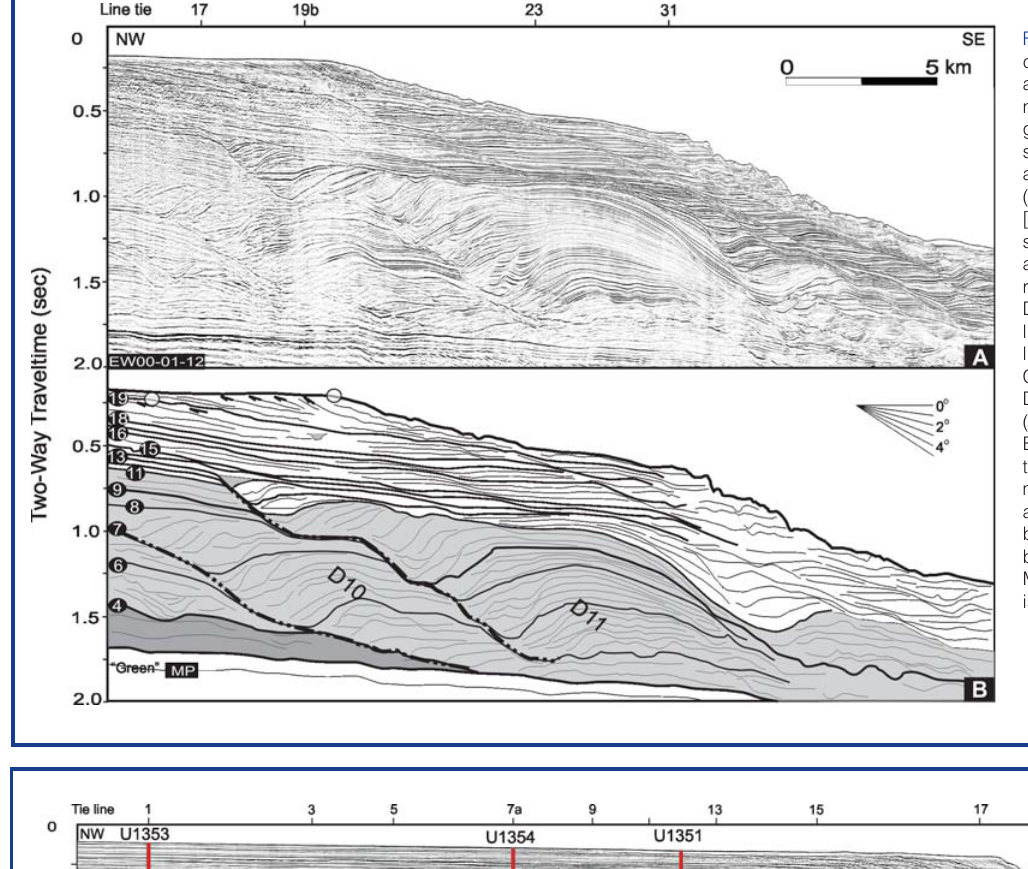
Figure 5. [A] Uninterpreted dip profile EW00-01-12 across the slope in the northern part of the survey grid showing mounded s e d i m e n t d r i f t s w i t h adjacent (landward) moats (see Fig. 2 for location). [B] Interpretation showing sequence boundaries and selected locations of reflection truncation (arrows). Drifts D10 and D11 are the last of the succession of large elongate drifts of the Canterbury Basin (Fig. 2). Drifts migrate northwestward (landward) on dip profiles. Erosional unconformities at the landward edges of drift moats are diachronous, and they are intersected by multiple sequence boundaries. The underlying Marshall Paraconformity (MP) is also